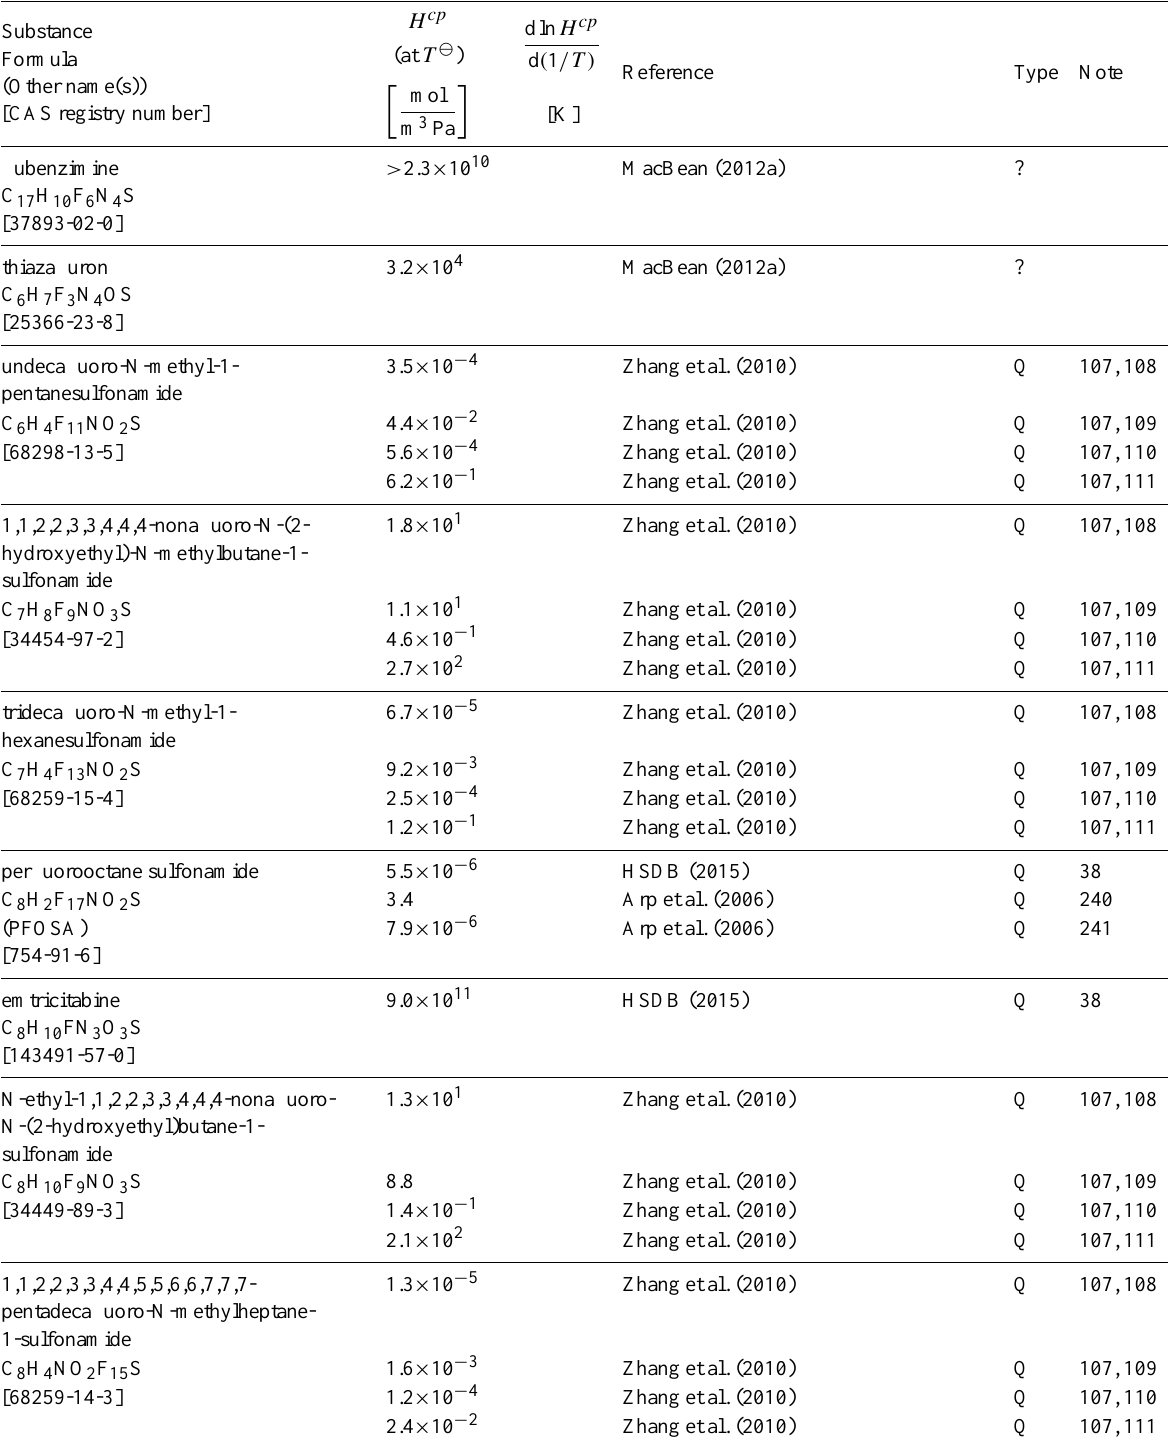
Table 6: Henry’s law constants for water as solvent